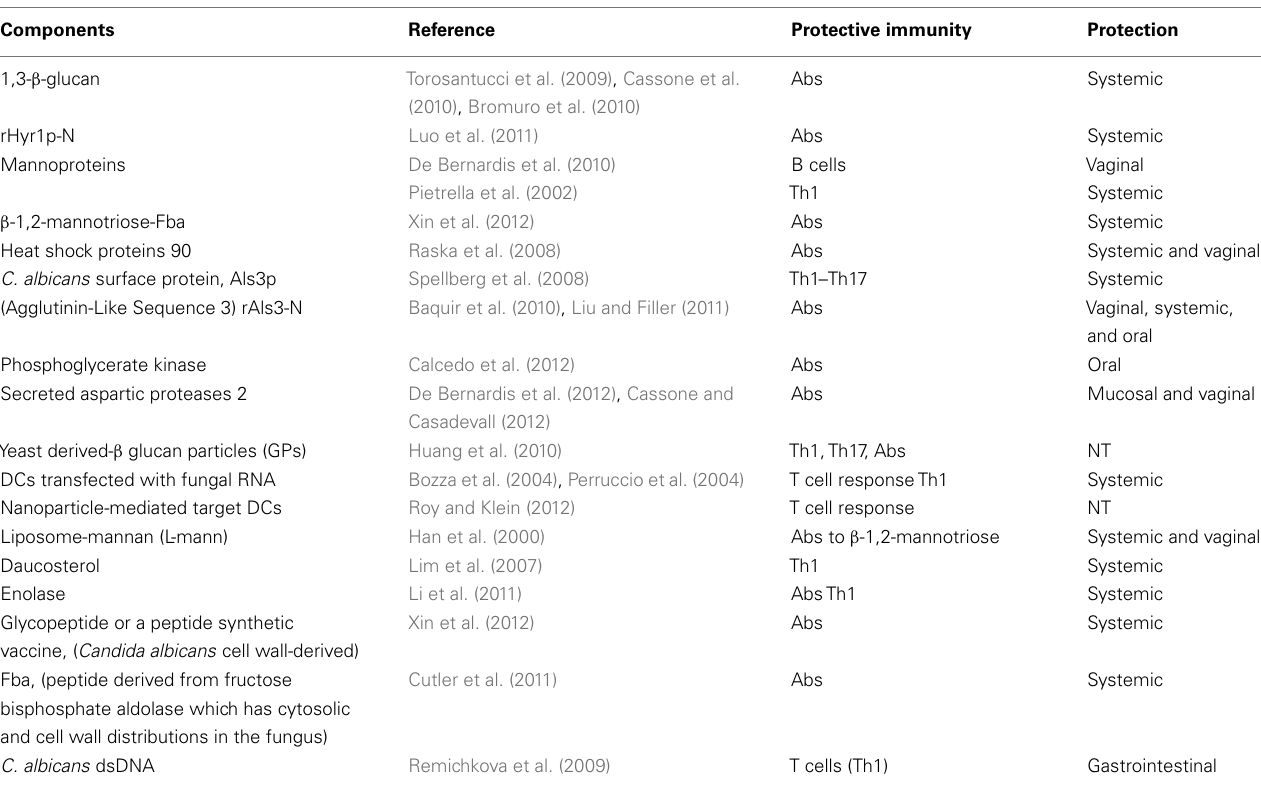
Table 1 |Vaccine candidates for protection against